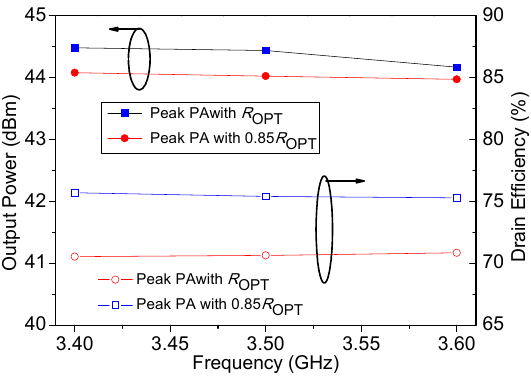
Figure 11. Simulated drain efficiency of DPA versus output power: ( a ) proposed DPA with 0.85 R OPT , and ( b ) conventional DPA with R OPT .